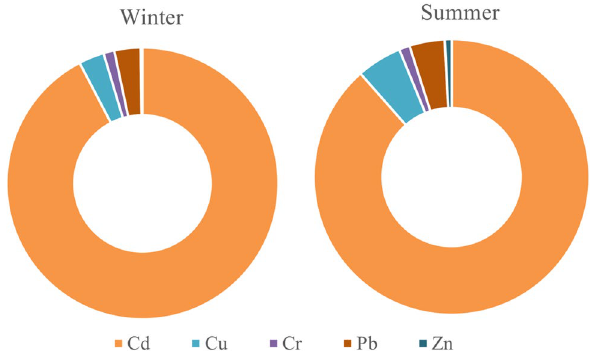
Table 3 Pearson’s correlation coefficients (r) among five heavy metals in surface sediment